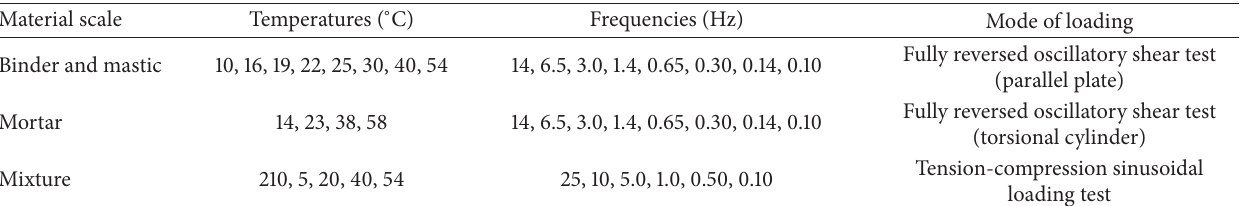
Table 3: Test methods of the multiscale asphalt materials.